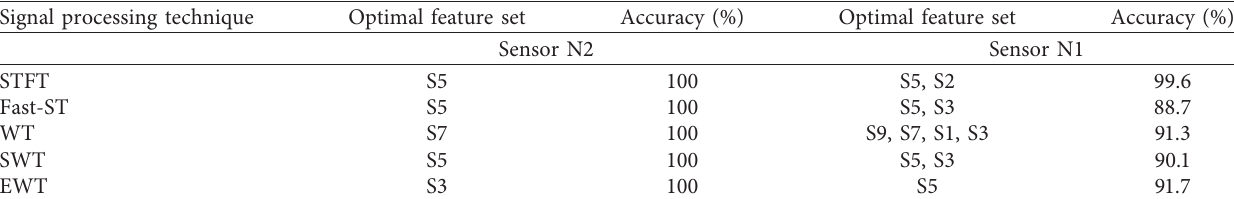
Table 2: Classification accuracy of the selected feature subset obtained by using different feature extraction methods for bridge health monitoring benchmark problem (case